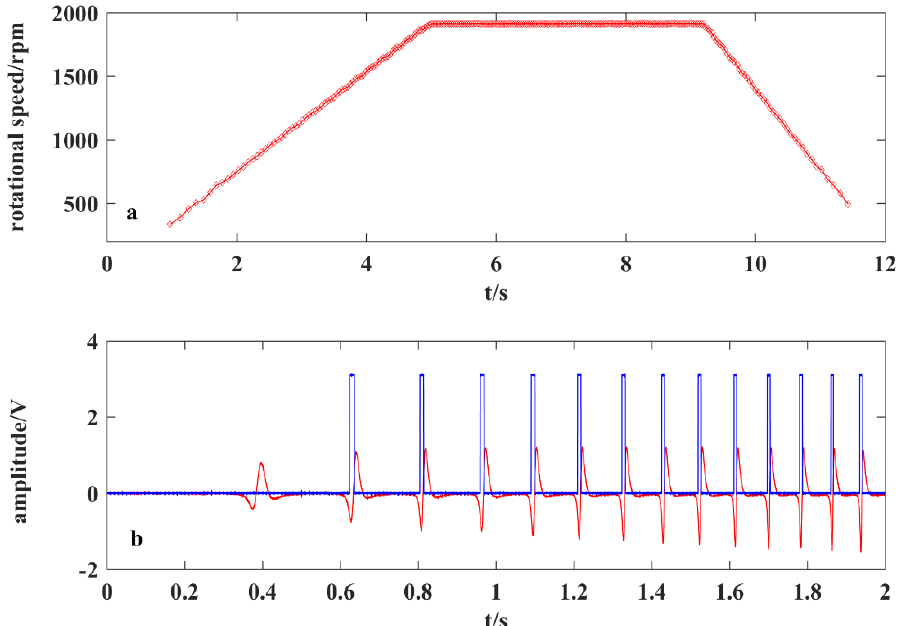
Figure22. ( a )Measuredrotationalspeedbythe T method; and( b Figure 22. ( a ) Measured rotational speed by the T method; and ( b ) waveform during acceleration process.